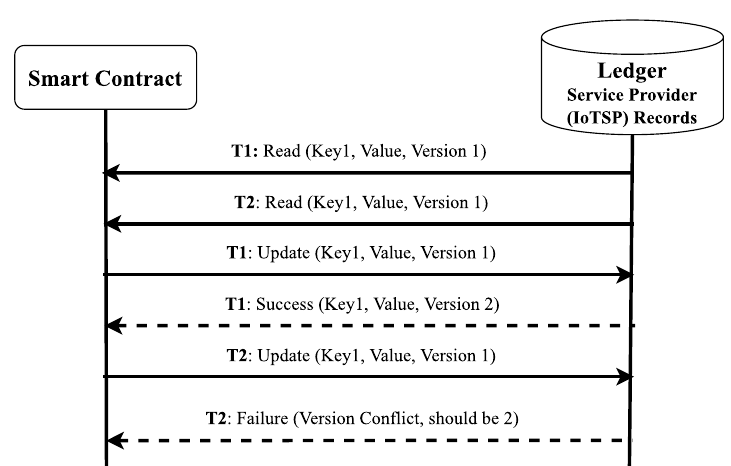
Fig. 13 Read-Write set conflicts caused by multiple transactions updating the same